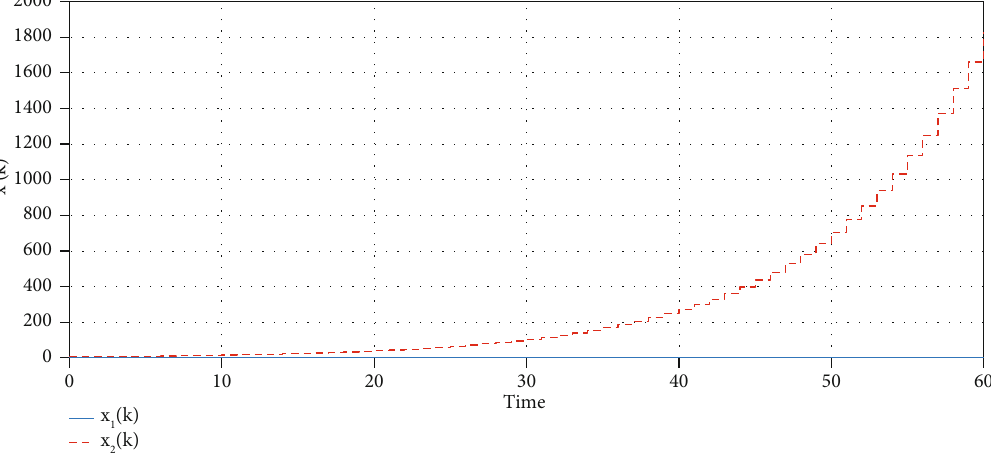
Figure 4: State response of the fi rst